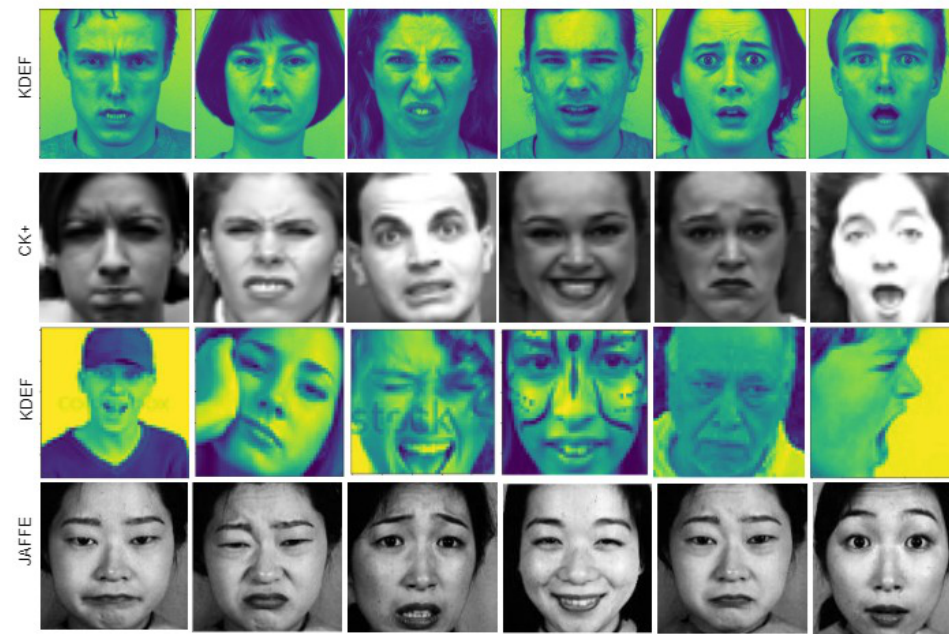
Figure 4. Sample Images of different datasets.